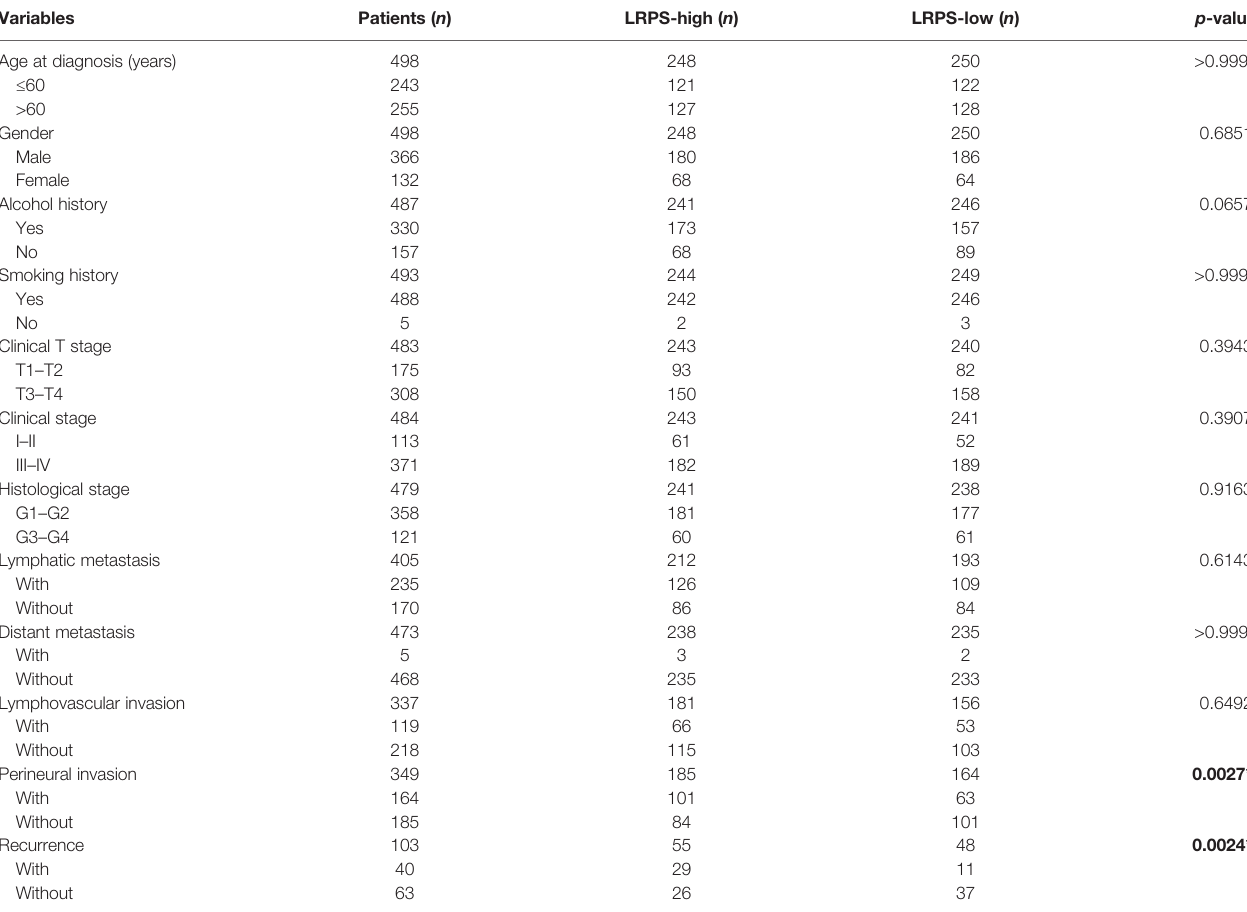
TABLE 2 | The differences of clinical pathological characteristics between LRPS-high and LRPS-low.